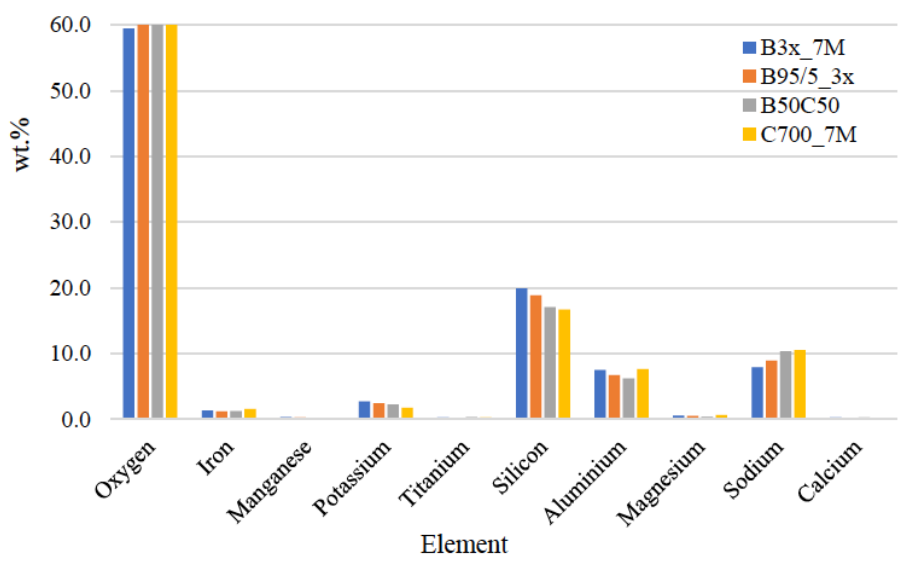
Figure 5. EDS analysis for the investigated samples.